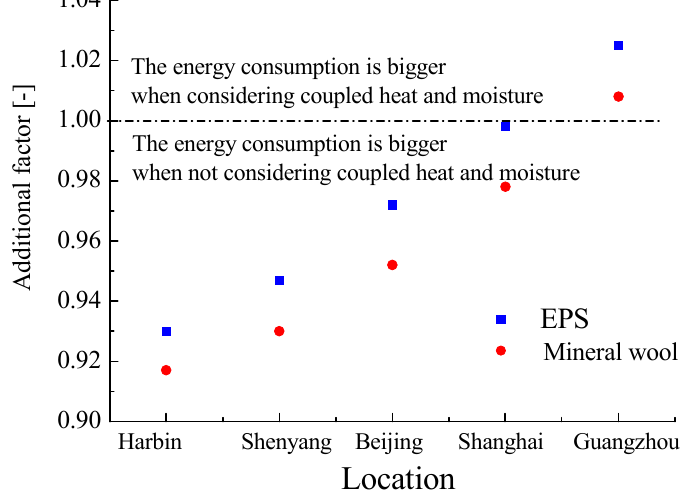
Figure 10. The correction factor of total energy consumption in official buildings in different areas.